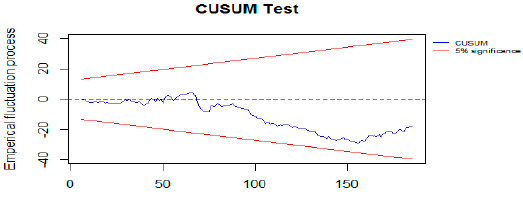
Figure 9. CUSUM test of processed cheese.